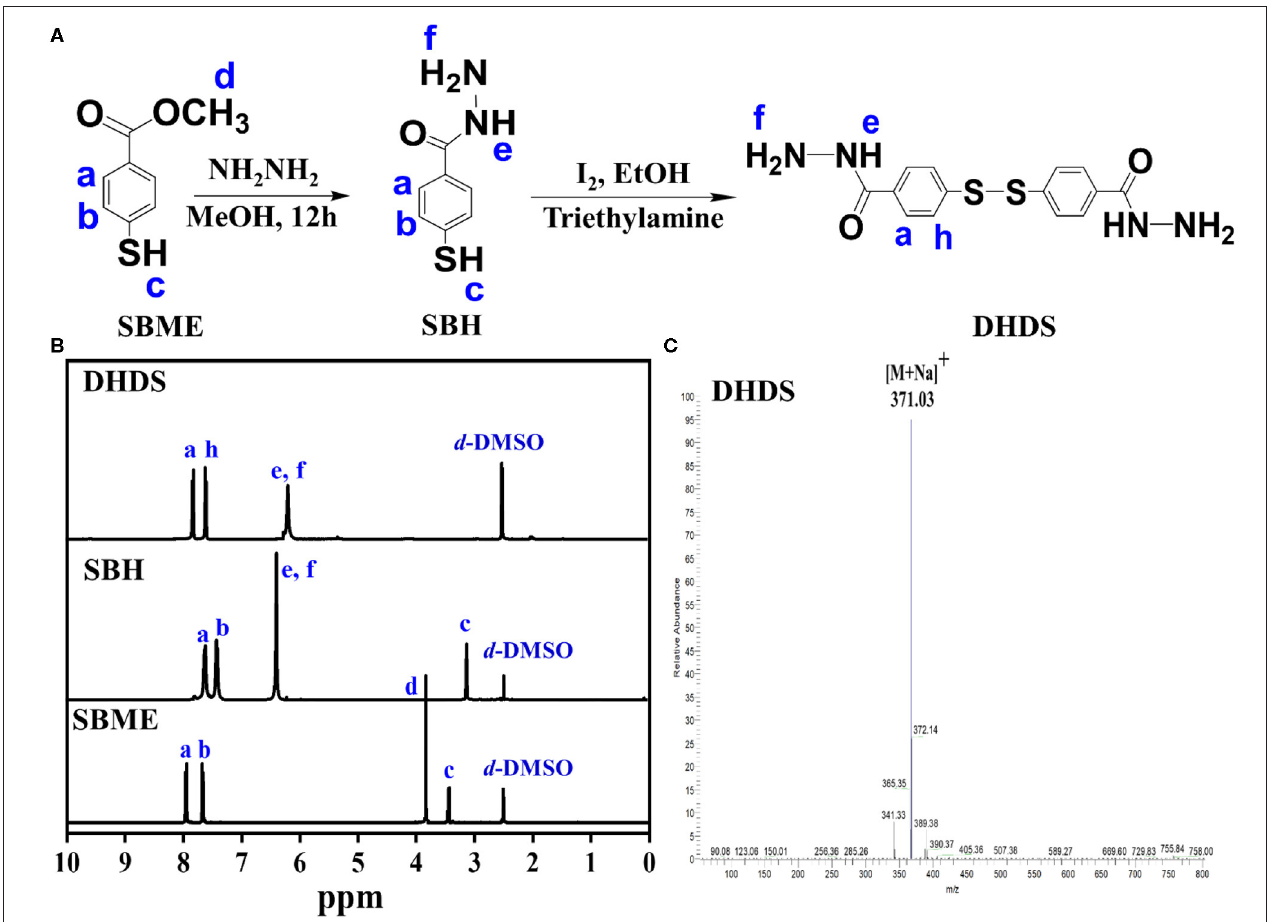
FIGURE 1 | Synthesis and characterization of DHDS. (A) Synthesis process; (B) 1 HNMR spectra of SBME, SBH, and DHDS; (C) ESI-MS spectrum of